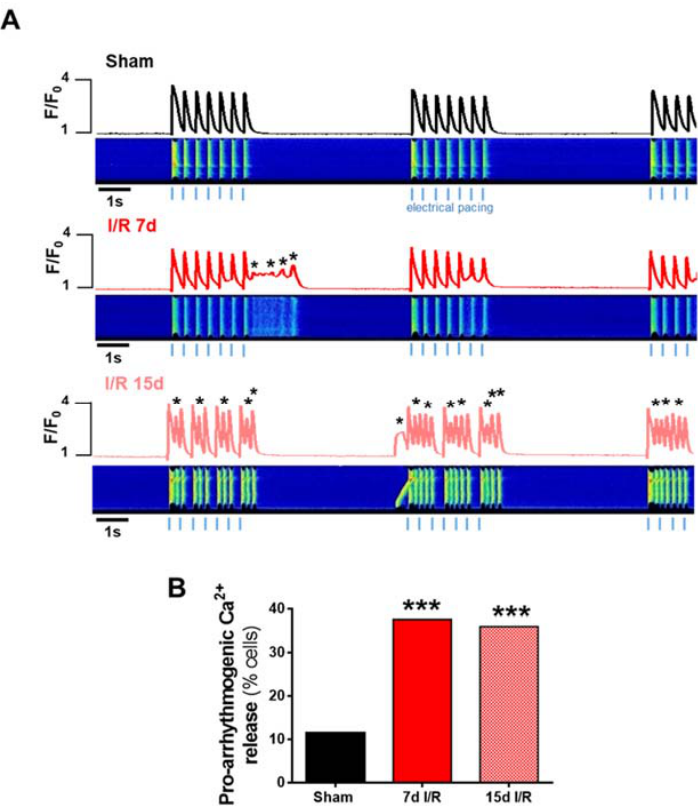
Figure 6. Pro-arrhythmogenic events in electrically stimulated cardiomyocytes. ( A ) Representative line-scan images and contraction profiles of cardiomyocytes from sham-treated mice and from mice subjected to ischemia and reperfusion (IR) for 7 and 15 days. Cardiomyocytes were electrically stimulated at 2 Hz in 7-pulse sequences. * Represents arrhythmic Ca 2+ events (spontaneous abnormal release of Ca 2+ as waves or automatic contractions). ( B ) Proarrhythmogenic Ca 2+ release following the arrhythmia protocol in cardiomyocytes. Data presented as % of total analyzed cells with events. Data are expressed as mean of continuous variables after Fisher test. *** p < 0.001 versus sham; sham ( n = 113 cells, N = 5 mice), 7d I/R ( n = 77 cells, N = 7 mice), 15d I/R ( n = 150 cells, N = 6 mice). In this protocol, each cell was recorded once for 30 s. Statistical analyses were performed per cell .